Question: Sum up the contents of this chart in one sentence.
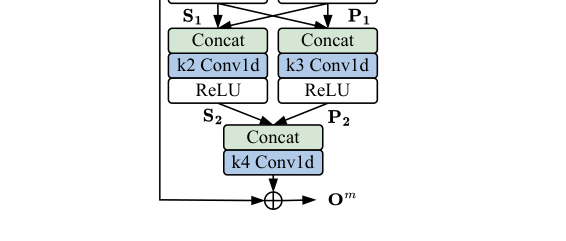
Answer: The structure of the multi-scale residual module (MSRM). k1, k2, k3 and k4 represent the kernel size of the respective 1D convolution layer.